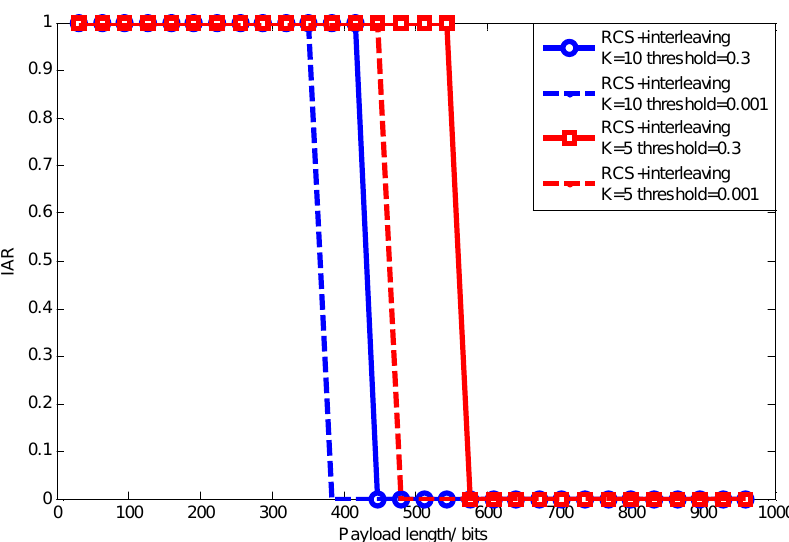
Figure 20. Signal transmission efficiency with varying